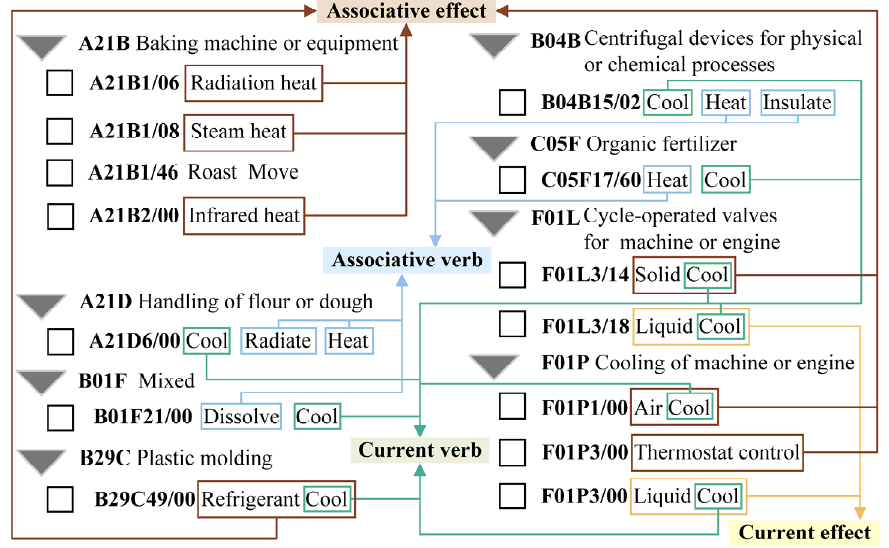
Figure 4. Example of the functional verb and effect descriptions in the IPC.